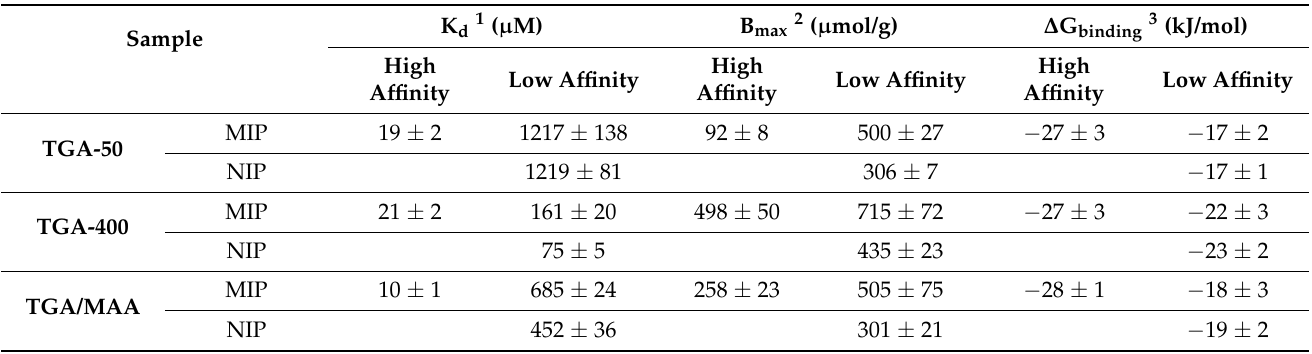
Table 2. Binding and thermodynamic parameters derived from the Scatchard plots for TGA-50, TGA-400, and TGA/MAA MIPs and